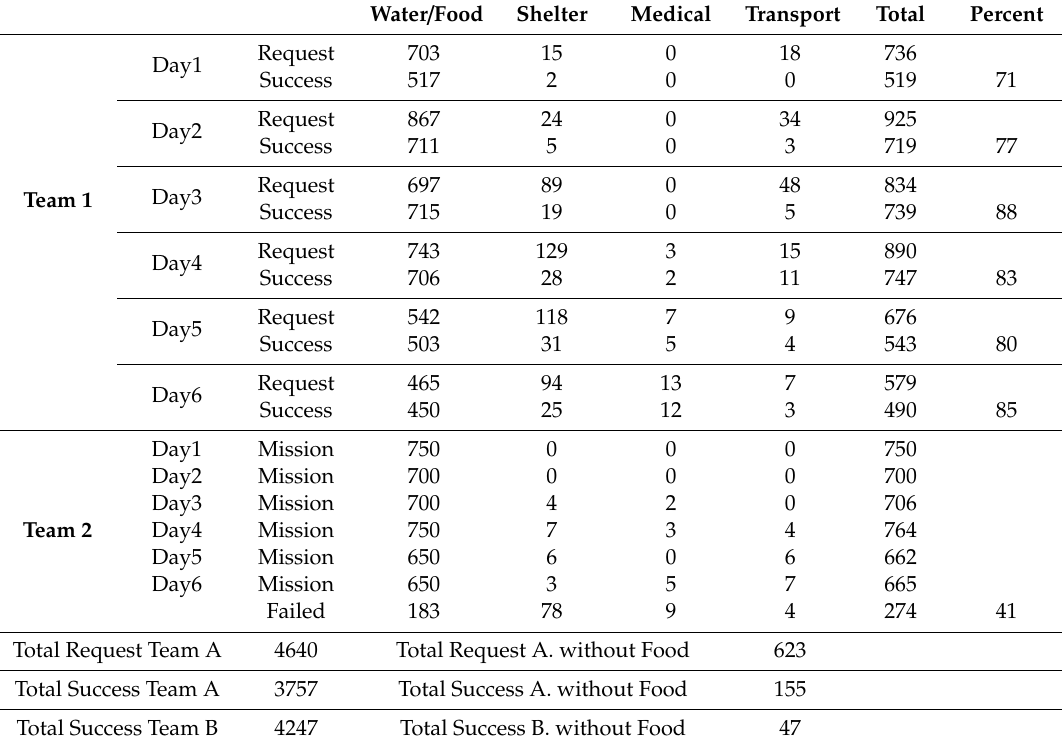
Table 2. Recorded information of missions, successes and the fails of rescue teams in six days. Water / Food Shelter